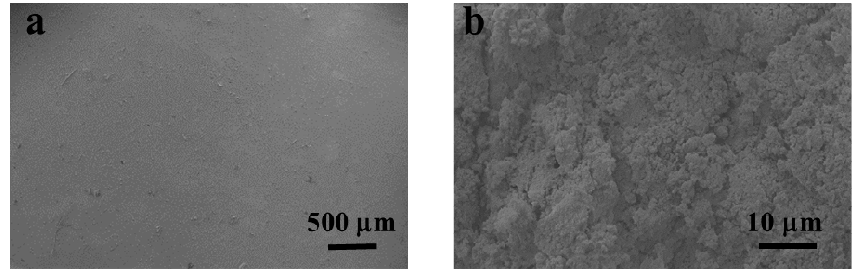
Figure 3. SEM images of the elastic membranes ( a ) before and ( b ) after laser ablation.